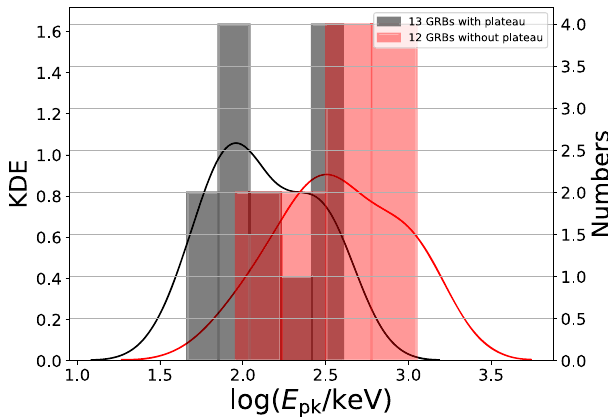
Fig. 6 |Distributionsofpeakenergy, E pk . The black bars represent the 13 GRBs with plateau phases in our sample, the red bars represent 12 GRBs without plateau phases presented in Table 6 of Ref. 51. Note that GRBs 050319, 061021 as well as early GRBs observed before the launch of Swift -BAT in Ref. 51 were discarded. In the panel the right-hand ordinate is the number of burst in each histogram bin and the left-hand ordinate is the value of the kernel density estimation (KDE), which is shown by the black and red curves for each sample respectively. Clearly, plateau bursts have a lower peak energy than other bursts. This result is consistent with the idea that jets in these bursts have a lowerinitialjetLorentz factor. We also performed aKolmogorov-Smirnovtest (KS test: D = 0.60 and p = 0.014) which can clearly show if these two samples originatefromthesame population.TheKStestresultshowsthatthere isonly 1.4% chance for these samples to have originated from the same population and they differ with 60%. We view this as another hint towards understanding the difference between GRBs that do show a plateau and those do not. The source data to reproduce this fi gure are provided as a Source Data fi